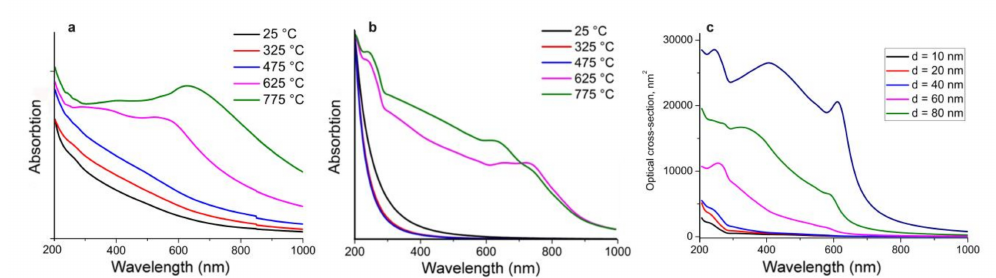
Figure 4. ( a ) Experimental and ( b ) simulated absorption spectra of germanium nanoparticles, sintered at di ff erent temperatures, and ( c ) calculated extinction optical cross-section of germanium nanoparticles of di ff erent